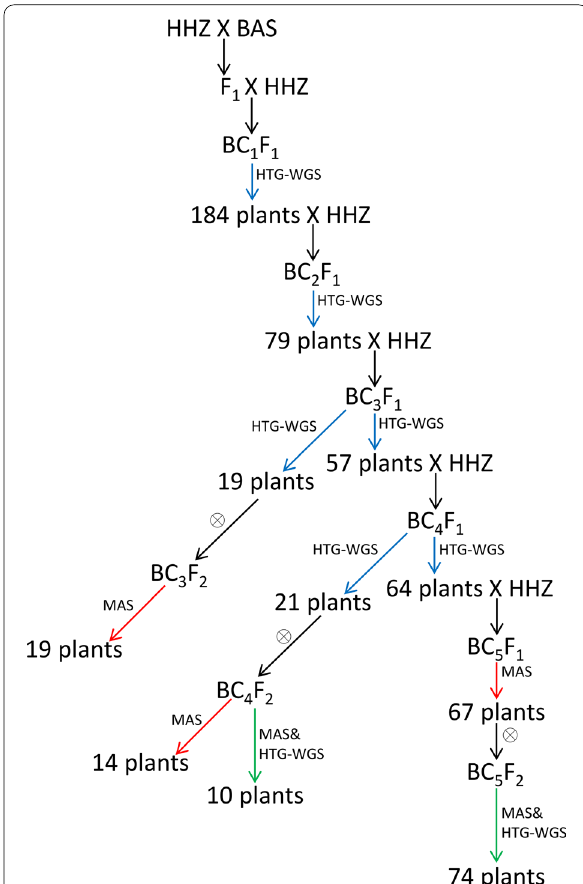
Fig. 1 Flow charts of the 117 CSSLs constructed in this study. The red arrow represents lines genotyped by MAS. The blue arrow represents lines genotyped by HTG-WGS (High-Throughput Genotyping by Whole-Genome Resequencing). The green arrow represents lines genotyped by MAS and HTG-WGS. The black circle represents